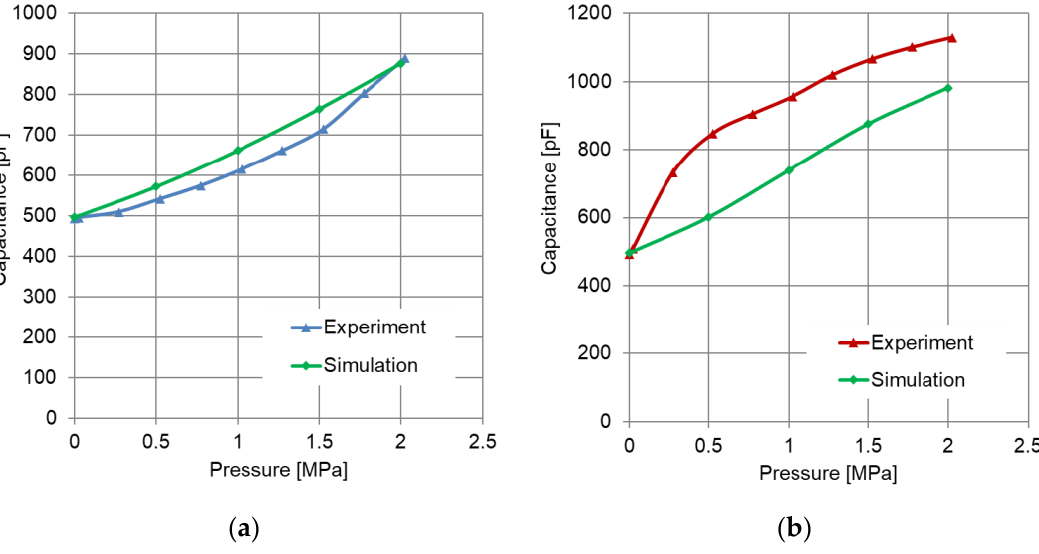
Figure 15. Comparison of the dependence of the capacitance of dielectric elastomer high-pressure sensors on the applied pressure received from experimental data and FEM simulations: sensor with hard flat plates ( a ) and sensor with elastic silicone plates with openings ( b ) [97].